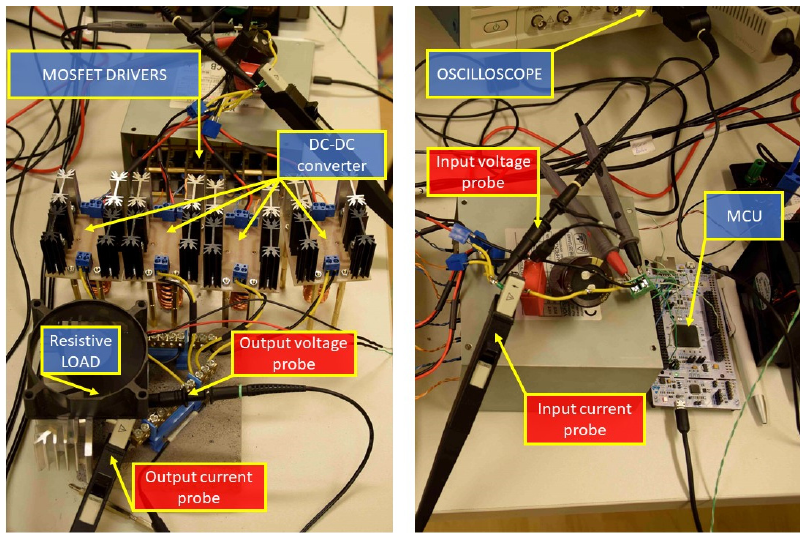
Figure 11. The block scheme of the experimental test.